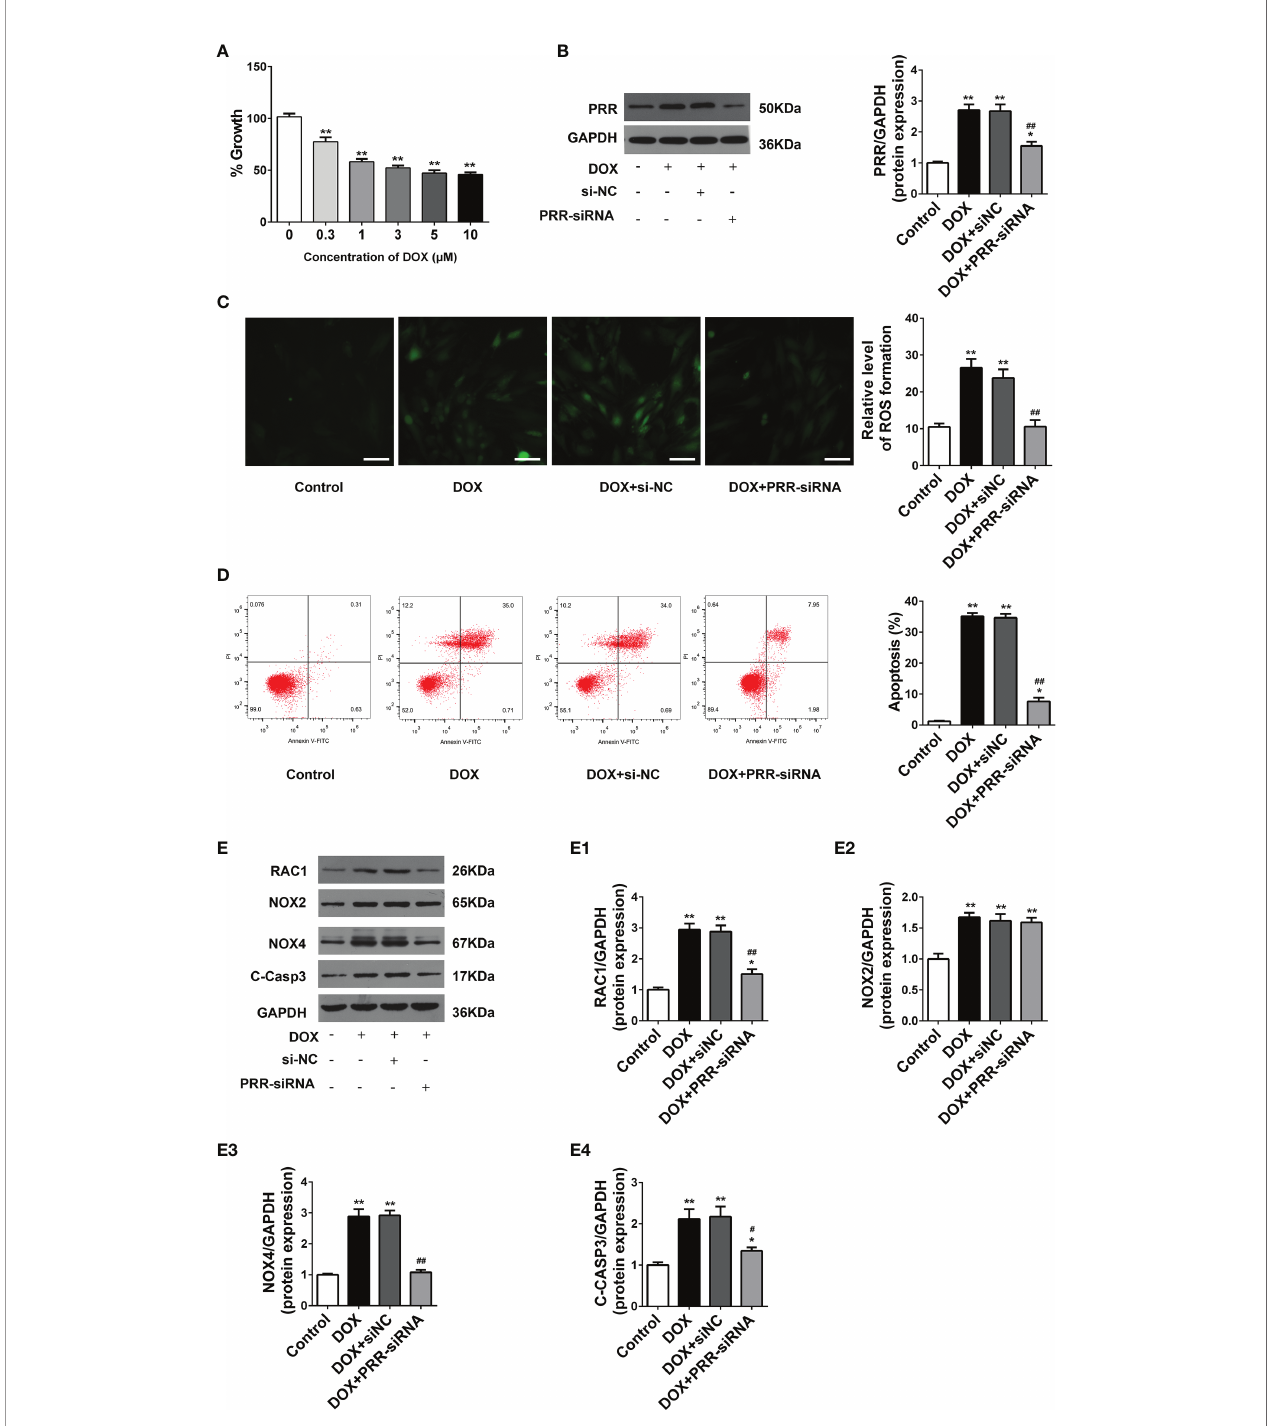
FIGURE 3 | PRR inhibition downregulated the overexpression of oxidant species and apoptosis in H9C2 cells treated with doxorubicin. (A) Cell viability of H9C2 cells treated with Doxorubicin (DOX) treated at different concentrations (0 – 10 m M). (B) The protein expression of PRR downregulated by PRR-siRNA in H9C2 cells. (B1) Quanti fi cation of PRR/GAPDH protein expression levels relative to changing PRR expression. (C) Representative oxidative stress based on DHE relative fl uorescence intensity of H9C2 cells. (D) Flow cytometry shows that PRR expression is directly related to cell apoptosis in doxorubicin (DOX)-treated H9C2 cells. (E) The protein expression of RAC1, NOX2, NOX4, and cleaved caspase3 was regulated by PRR inhibition in H9C2 cells. (E1)-(E4) Quanti fi cation of RAC1/GAPDH, NOX2/GAPDH, NOX4/GAPDH, and cleaved caspase3/GAPDH protein expression levels relative to changing PRR expression. (* p < 0.05, ** p < 0.01 vs the control group. # p < 0.05, ## p < 0.01 vs DOX